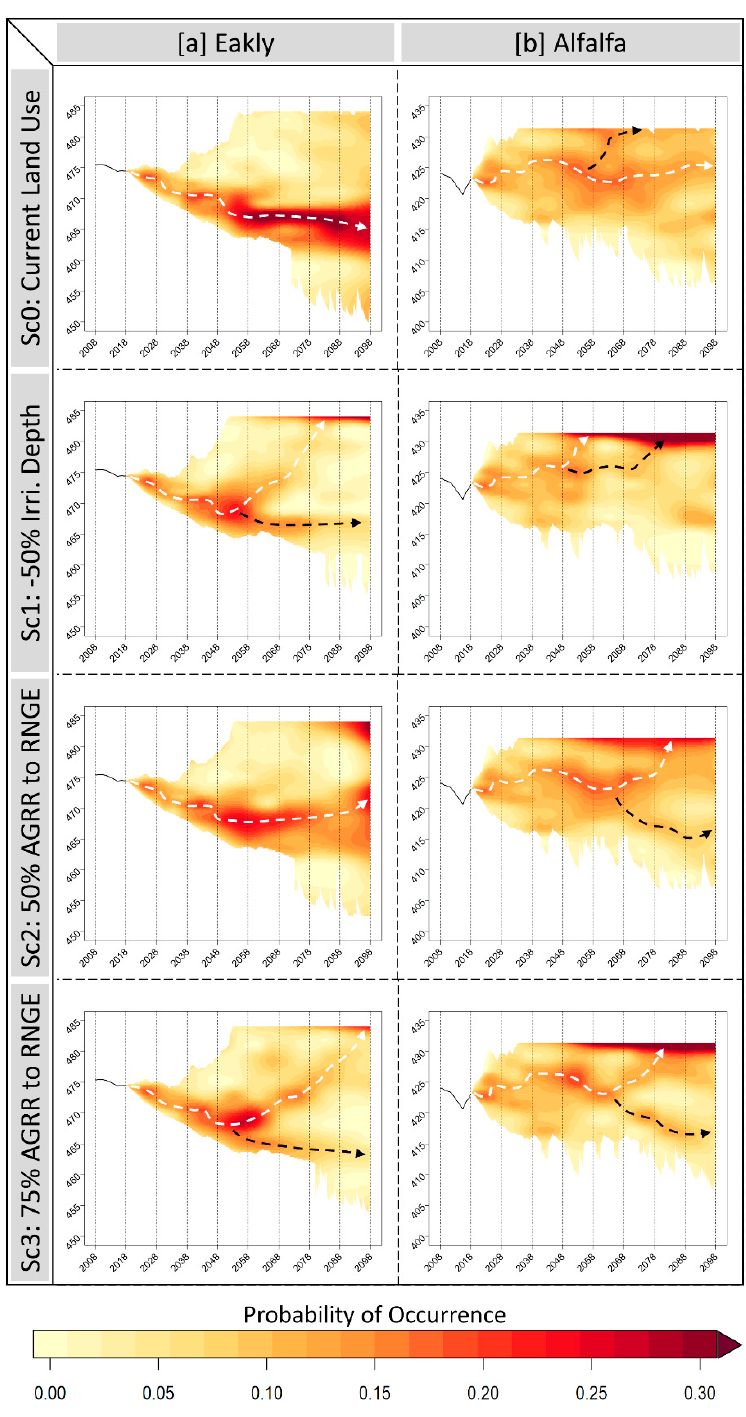
Figure 7. Groundwater levels (m) at the ( a ) Eakly and ( b ) Alfalfa monitoring wells for the baseline (Sc0) and three integrated climate and land use scenarios (Sc1–Sc3). Primary paths (white dotted lines) represent clearly defined continuous pathways that incorporate likely to most likely events, while secondary paths (black dotted lines) describe likely to less likely alternative pathways.